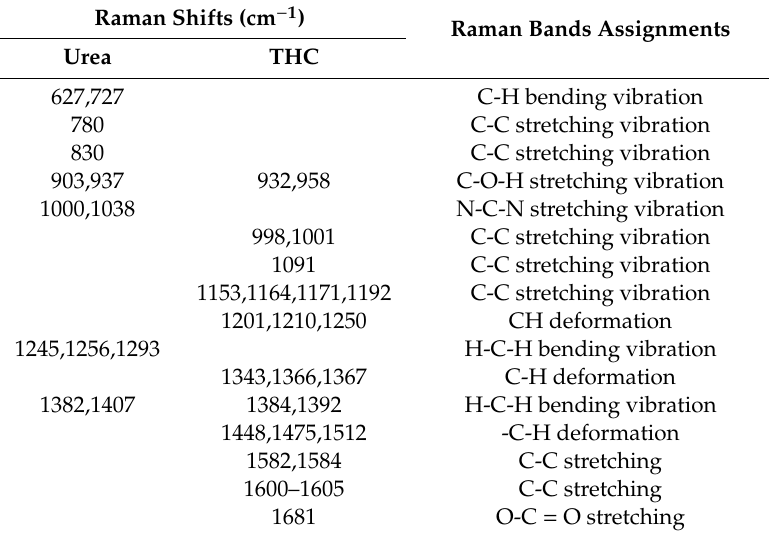
Table 1. Assignment of Raman peaks for urea and THC